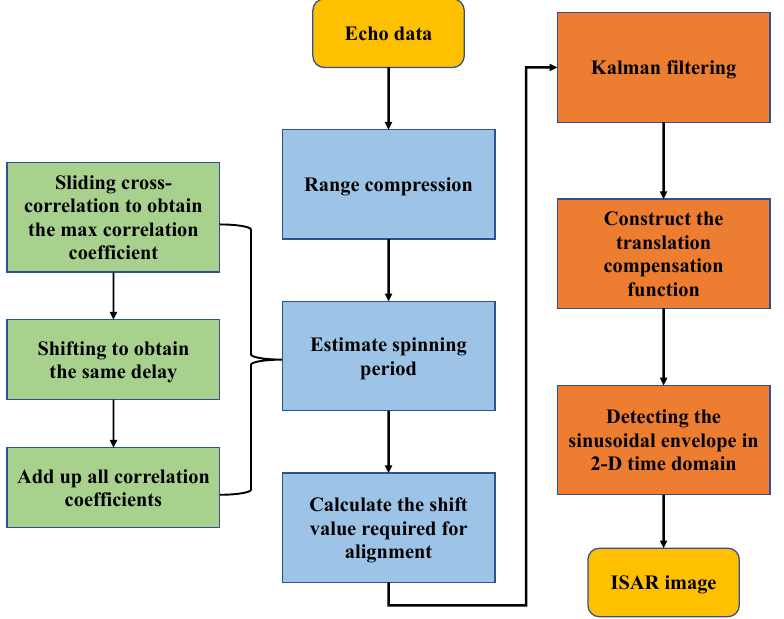
Figure 7. Whole flowchart of proposed method.